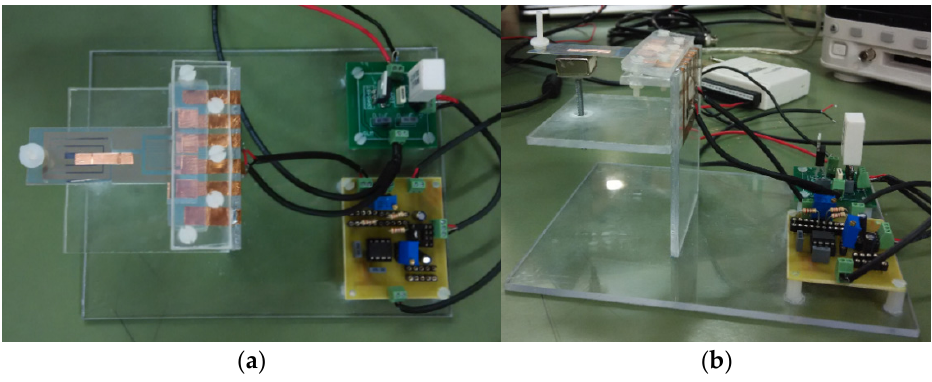
Figure 5. The developed mass sensor prototype. Top view ( a ) and lateral view ( b ).